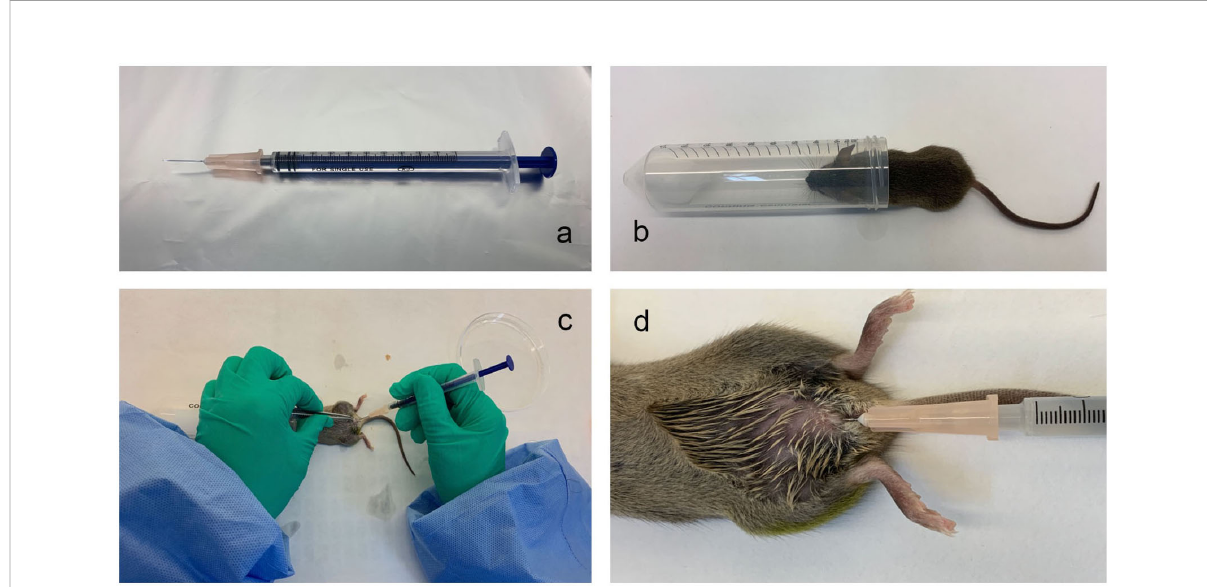
FIGURE 1 The mouse urinary tract infection model established by transurethral intravesical instillation of UPEC CFT073. (A) , The bladder injection device; (B) , The anaesthesia device; (C, D) , The operation method for the transurethral infusion of the bacterial fl